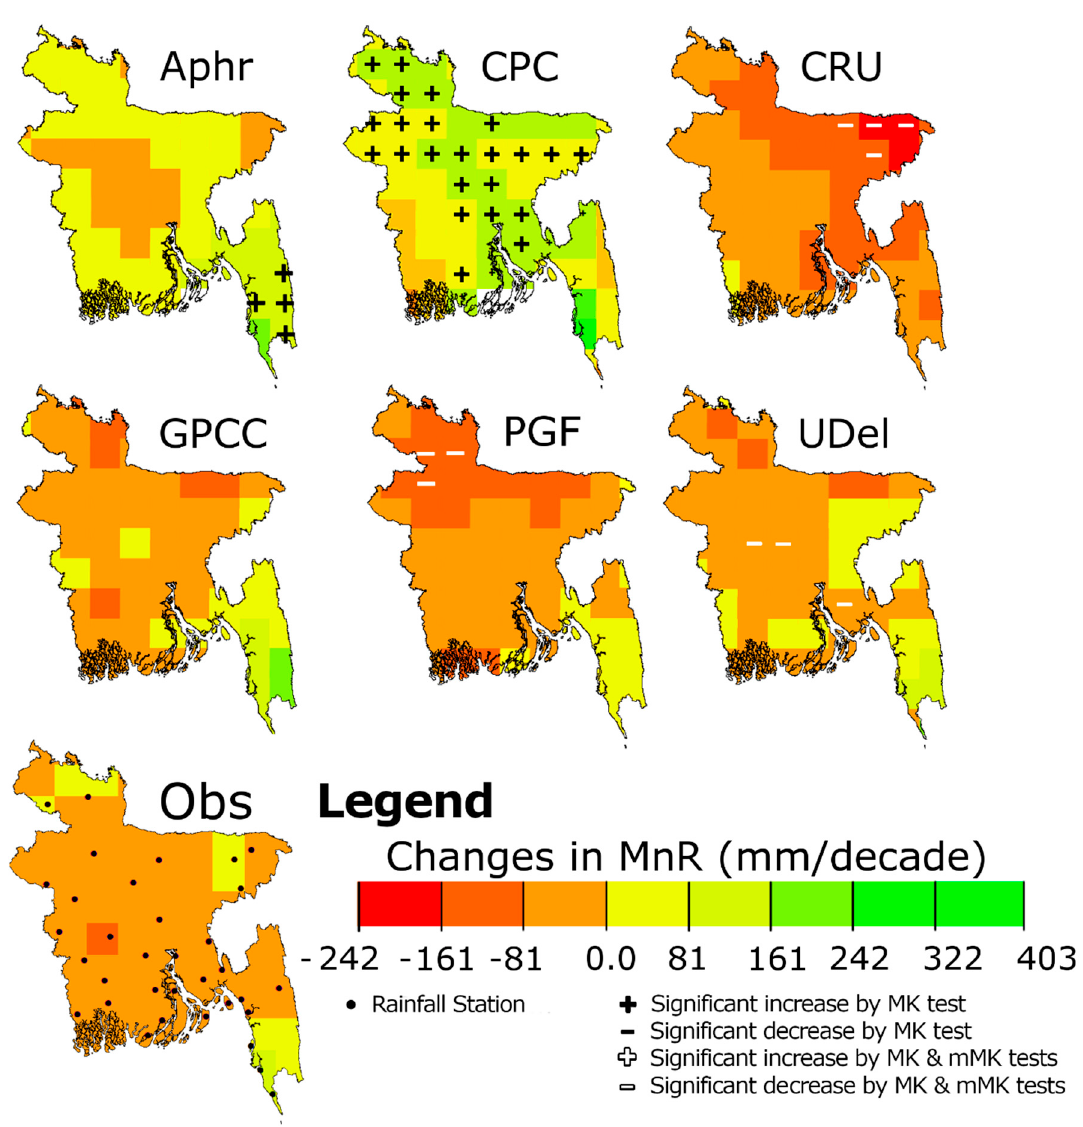
Figure 10. Trends in monsoon rainfall (MnR) in Bangladesh during 1979–2010.